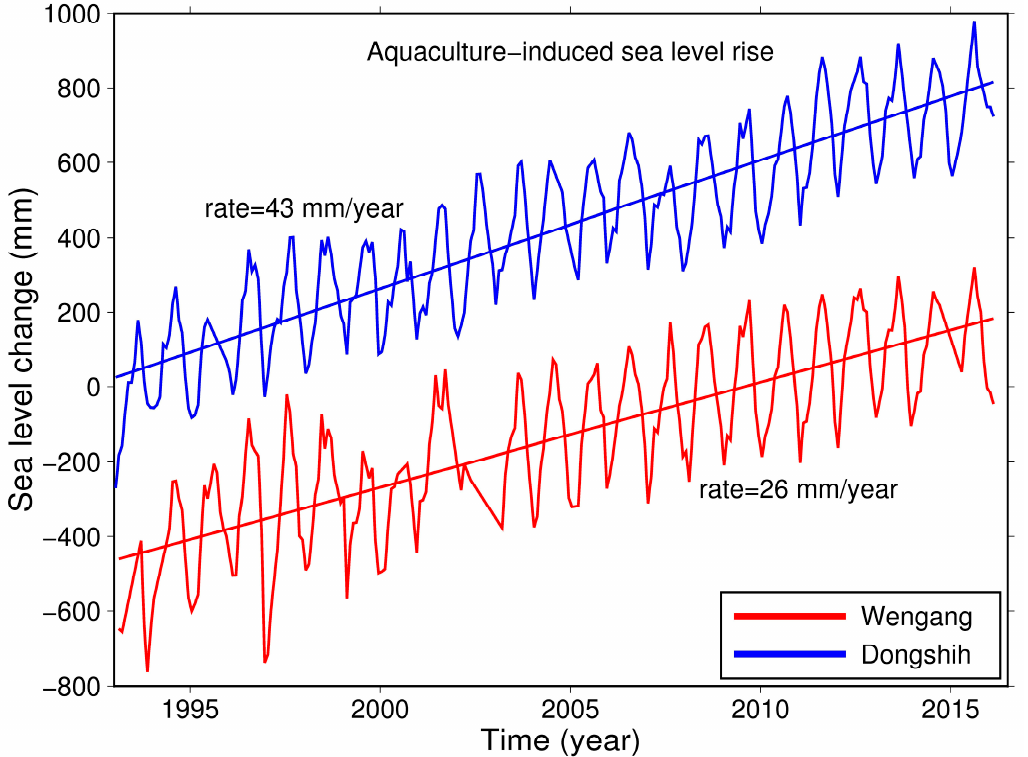
Figure 15. Tide gauge records at the aquaculture-rich Dongshih and Wengang (DSTG and WGTG, Figure 2a) in Chiayi, showing relative sea level rises caused by land subsidence.